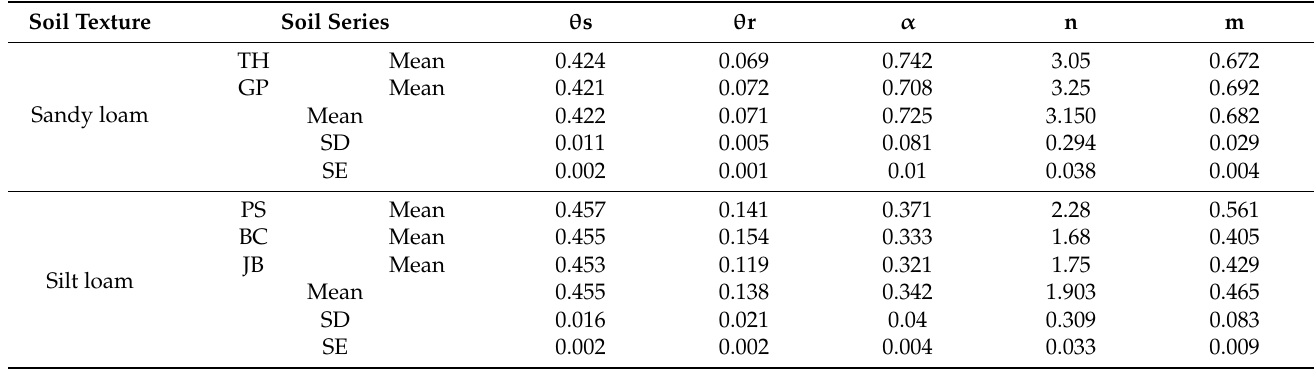
Table 4. Estimated vG model parameters using RETC for five soil